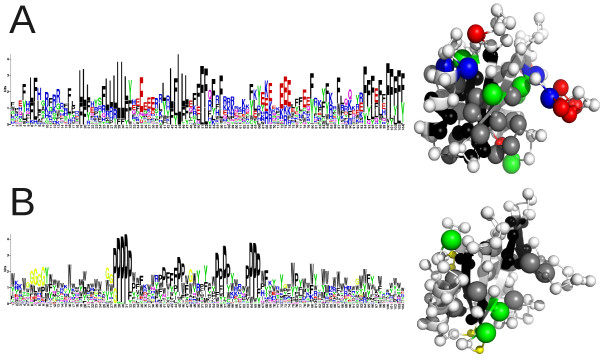
Highly stable sequences and structures for the SAP protein conformation for the informational (A) and physics-based (B) scoring functions. Residue frequency distribution in such sequences is shown as a sequence logo (left), and positions with more than 2 bits of Shannon information are mapped onto the structure of SAP with equivalent colors (right, non-informative positions shown in white).